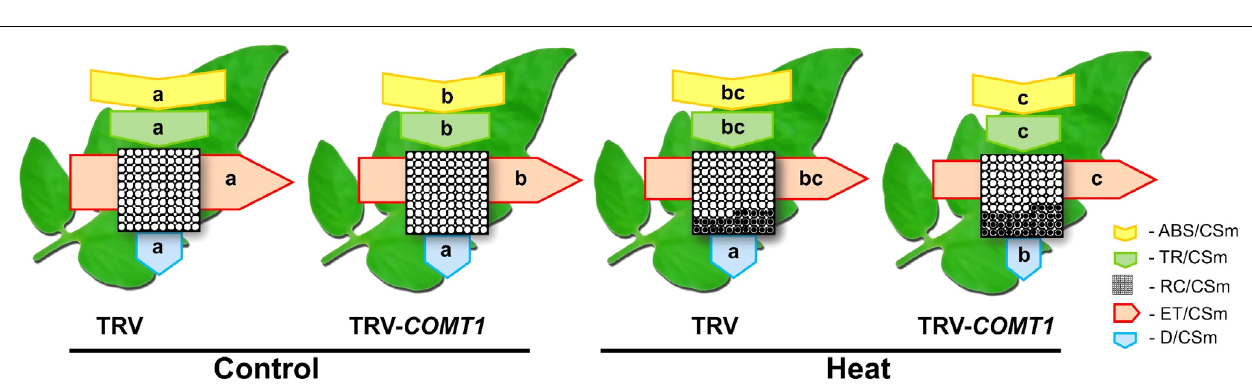
FIGURE 3 | Energy pipeline leaf models of phenomenological fluxes (per cross-section, CS) in the third fully expanded leaf in tomato as influenced by COMT1 silencing and heat stress. The results are expressed as the mean values ± SE, n = 6. Each relative value is drawn by the width of the corresponding arrow, standing for a parameter. Empty and full black circles indicate the percentage of active (Q A reducing) and non-active (non-Q A reducing) reaction centers of photosystem II (PSII), respectively; ABS/CSm, photon flux absorbed by the antenna pigments per CS; TR/CSm, trapped energy flux per CS; ET/CSm, electron transport flux per CS; D/CSm, non-photochemical quenching. Different letters indicate significant differences ( P < 0.05) according to the Tukey’s